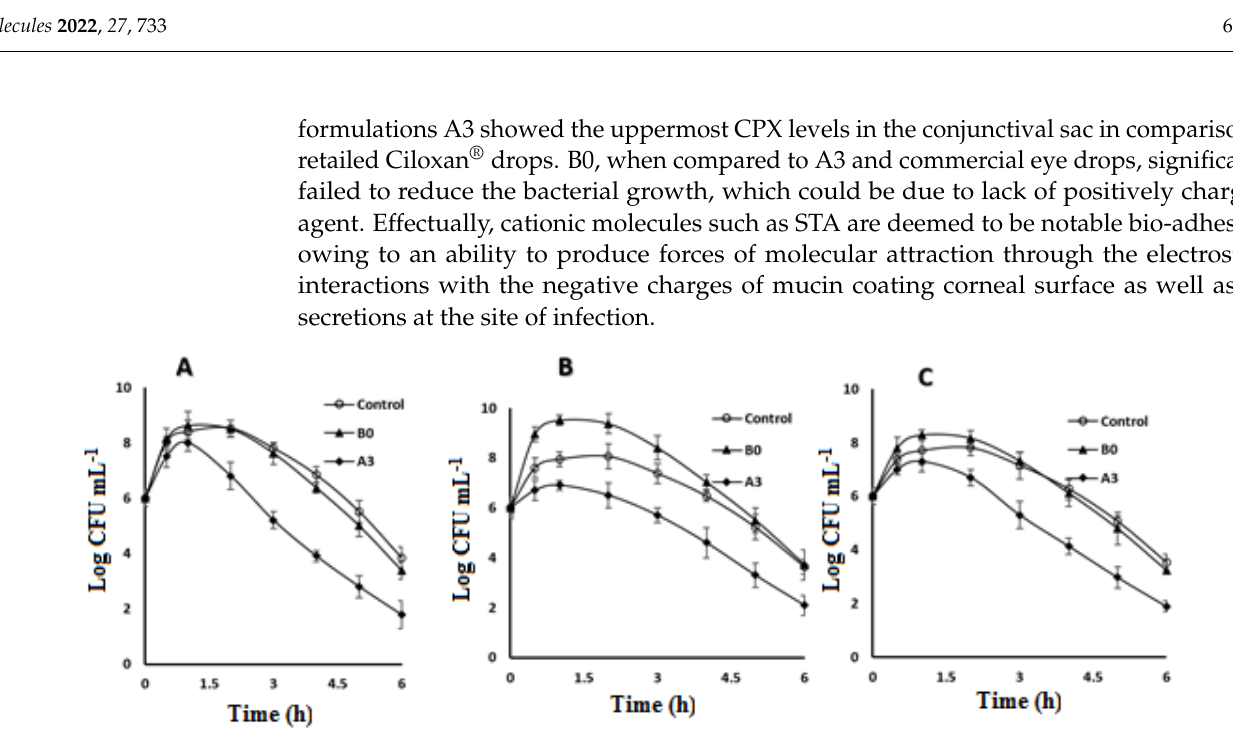
Figure 4. Colony count of the infected aqueous humor after the topical application of B0 and A3 formulations and Ciloxan ® eye drops against S. aureus ( A ), K. pneumonia ( B ), and P. aeruginosa ( C ), (mean ± SD, n = 3.0).